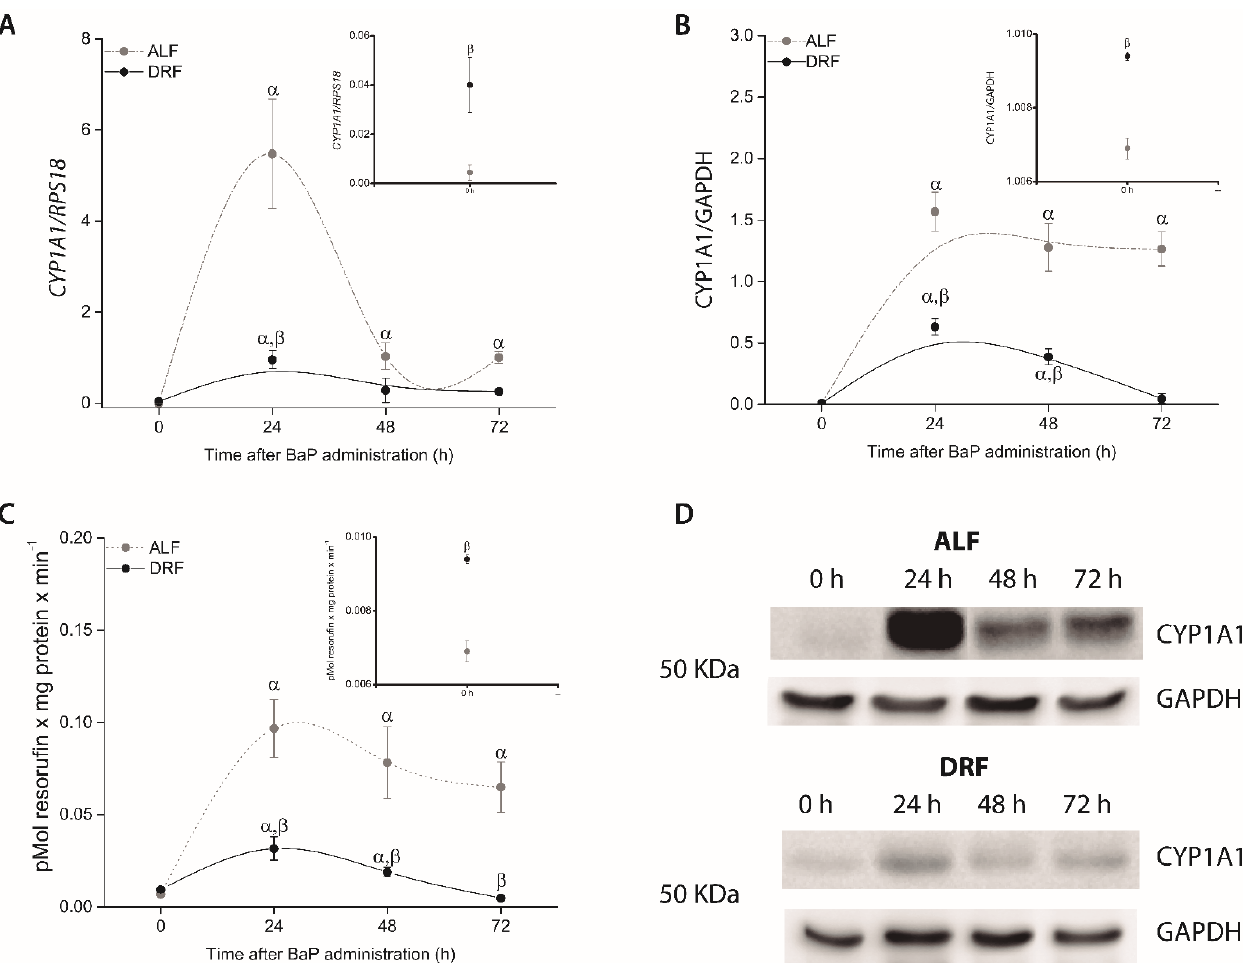
Figure 2. mRNA ( A ), protein levels ( B , D ), and activity of CYP1A1 ( C ) in the livers of rats in the ALF (gray circles) and DRF (black circles) groups after 10 mg/Kg BaP administration. Values correspond to the mean ± SEM, n = 6. α p ≤ 0.05 compared to the control group with the same diet (DRF at ZT1 and ALF at ZT13) and β p ≤ 0.05 compared to the ALF group at the same time points.